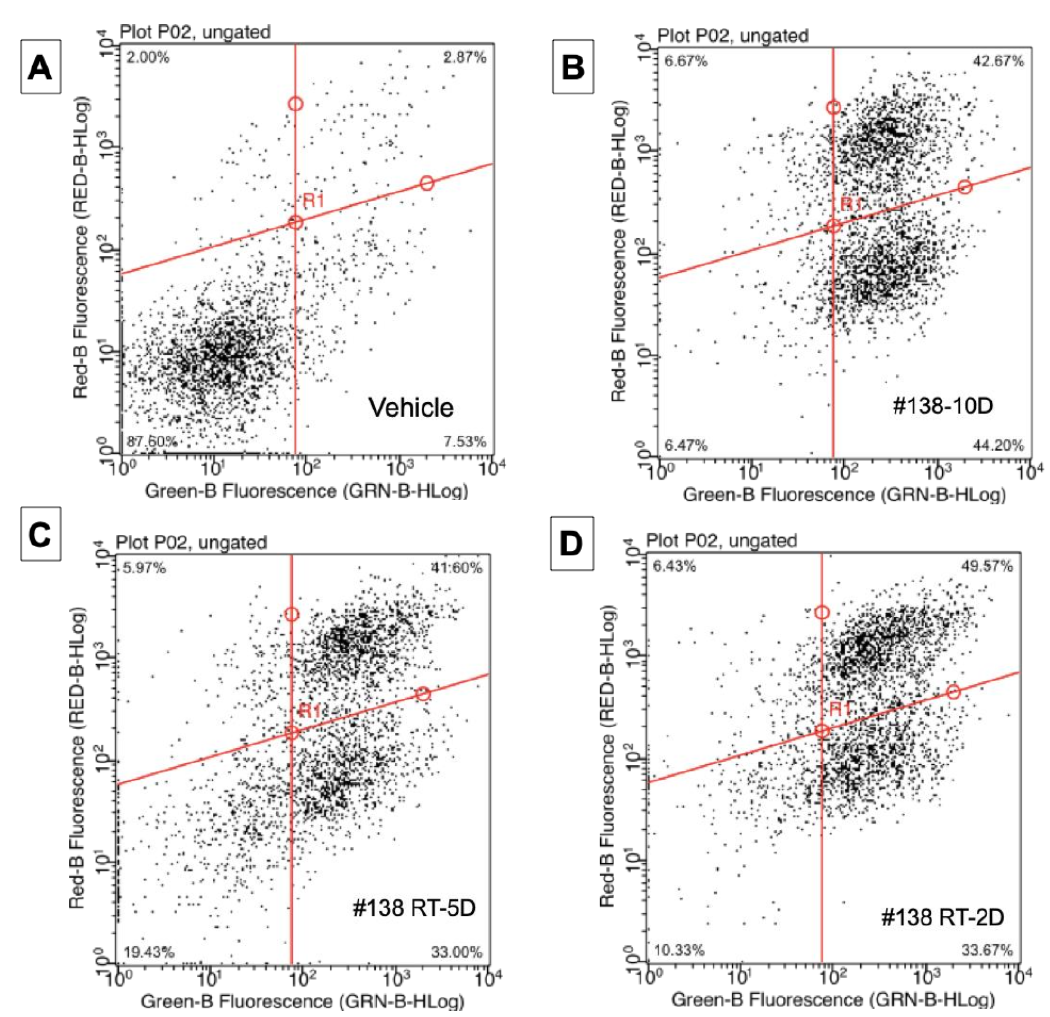
Figure 3. Apoptosis induced by ethanolic extracts on AsPC-1 pancreatic cancer cells. Cells were treated with 80 µ g/mL of each extract for 24 h, then analyzed by capillary cytometry (annexin-V and PI staining). Dot plots ( A ) vehicle, ( B ) extract #138-10D ( C ) extract #138 RT-5D ( D ) extract #138-2D, with % of living cells (bottom left annexin-V (cid:9) , IP (cid:9) ), early and late apoptosis (right column: annexin-v ⊕ , early IP (cid:9) or late IP ⊕ ) and cells in necrosis (top left: annexin-v (cid:9) , IP ⊕